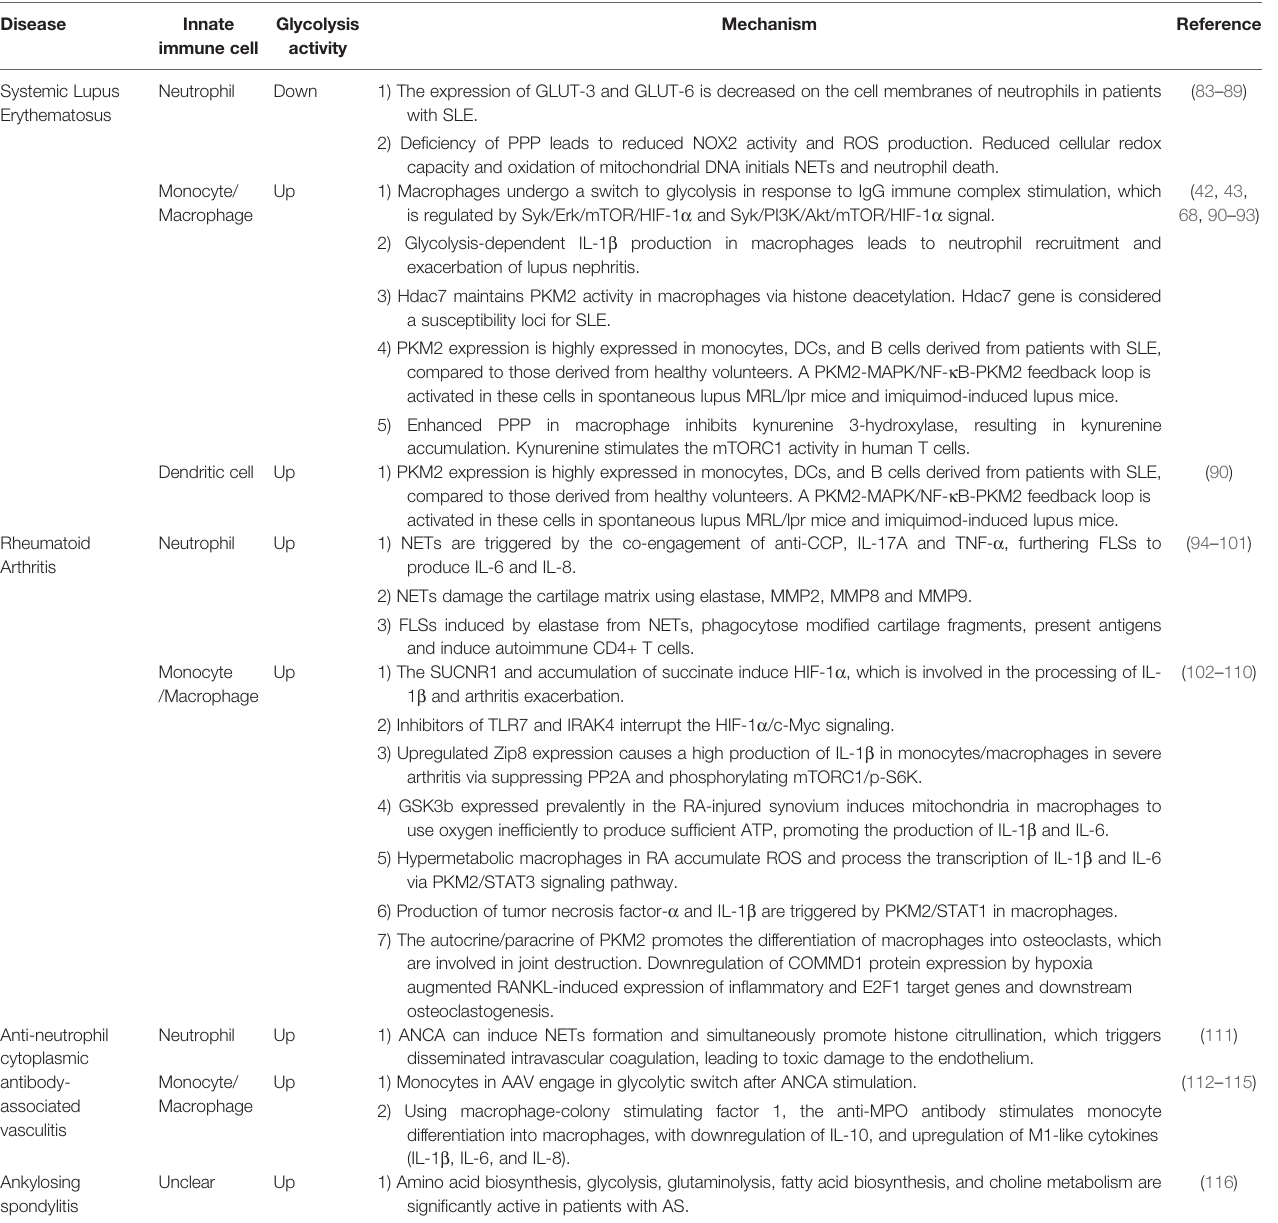
TABLE 1 | The primary features of glycolysis and innate immune cells in